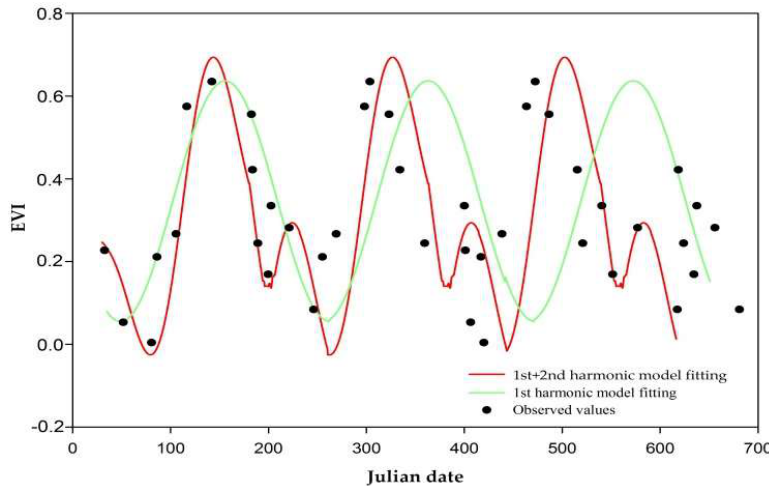
Figure 3. The phenological trajectory of cropland collected from Landsat OLI time-series image in 2015, and the fitting results by including different components of the harmonic model (1st harmonic model and 1st + 2nd harmonic model).